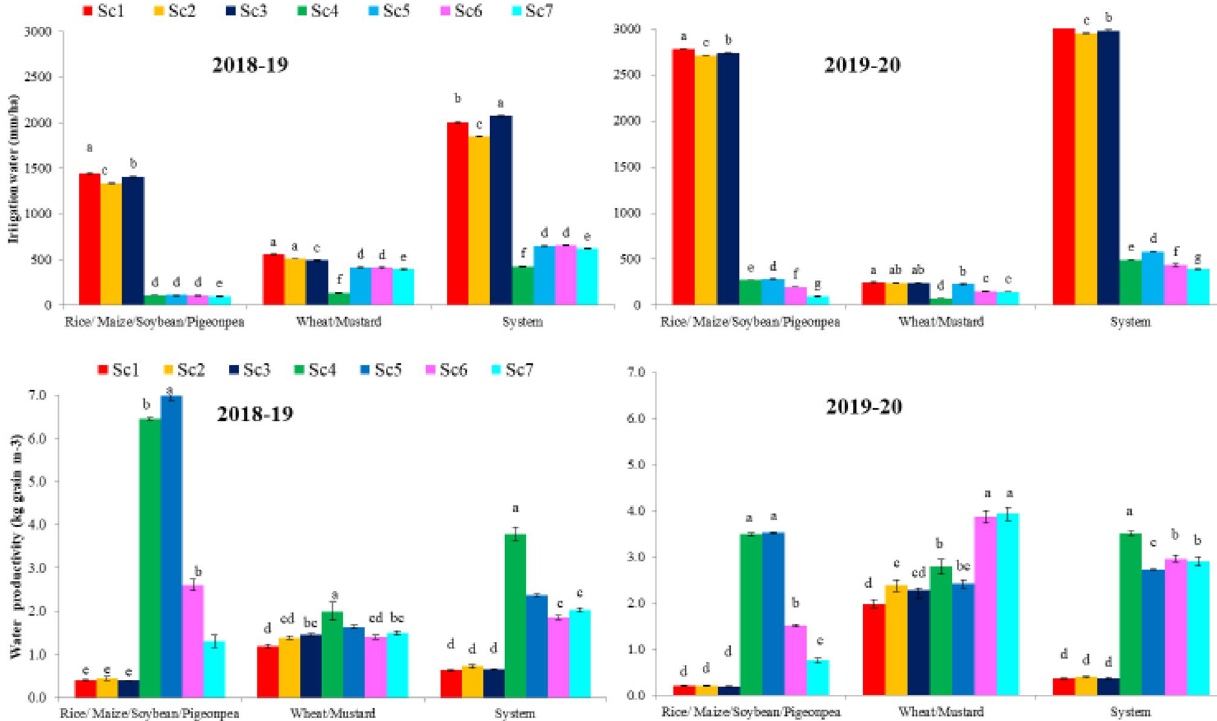
Figure 2. Irrigation water use (mm ha −1 ) and water productivity (kg grain m −3 ) as affected by different cropping systems under various management scenarios (2 years